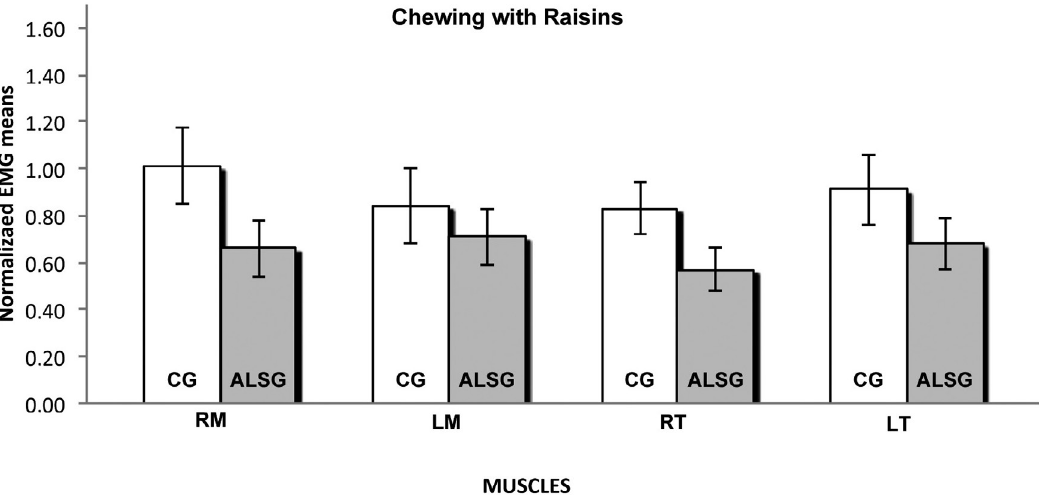
Figure 7- Normalized electromyography data of masseter (RM: right masseter; LM: left masseter) and temporalis (RT: right temporal; LT: left temporal) muscles for CG and ALSG in the chewing with